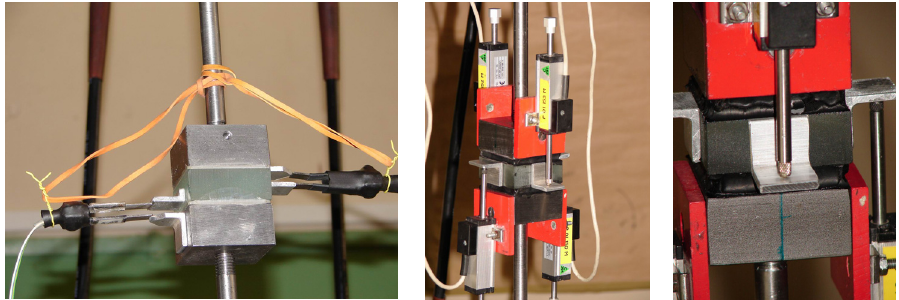
Figure 4a, b and c: Tension tests, different devices used to measure the deformation of the adhesive